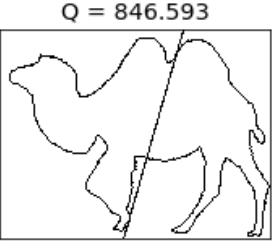
Figure 6. An unsymmetrical camel contour. Q is the asymmetry measure.